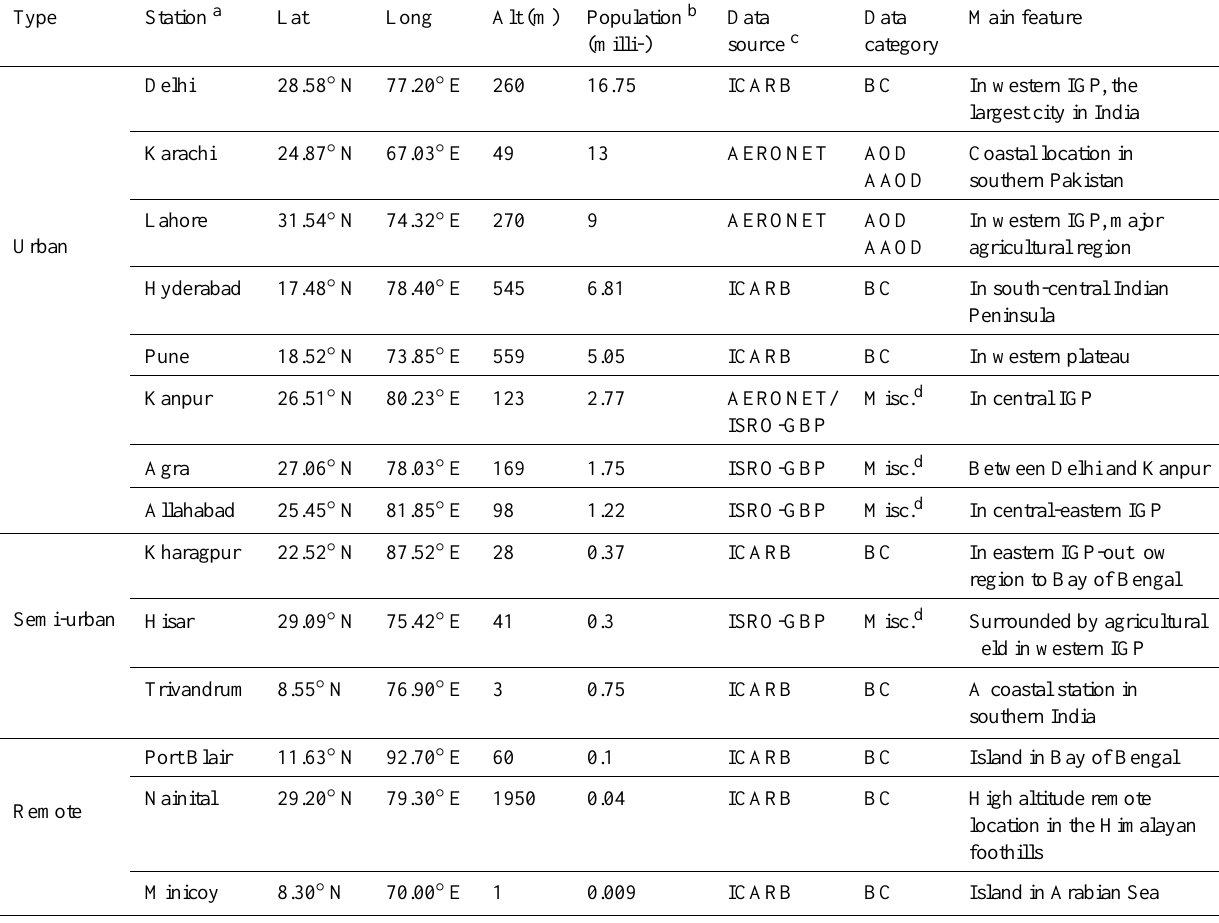
Table 2. Summary of stations in South Asia used in this